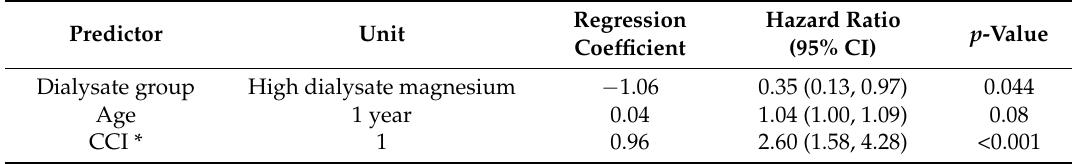
Table A2. Variables in the equation for adjusted Cox proportional hazards regression.